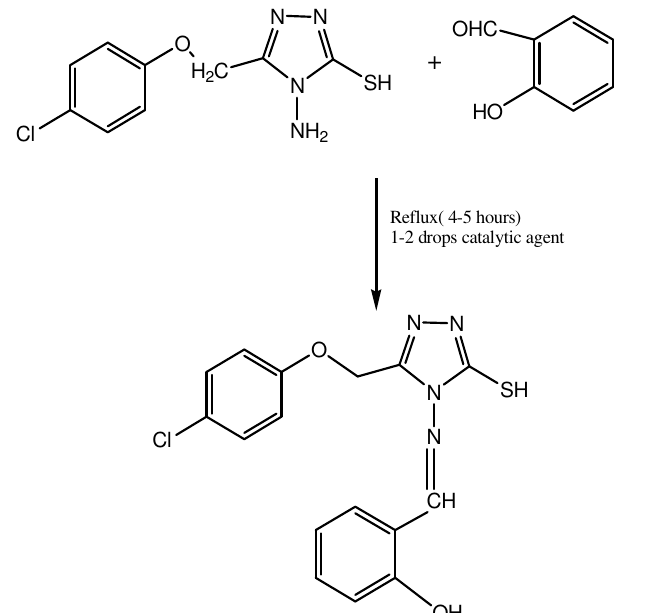
Figure 1. 2-[(E)-({3-[(4-chlorophenoxy)methyl]-5-mercapto-4H-1,2,4-triazol-4-yl}imino] phenol